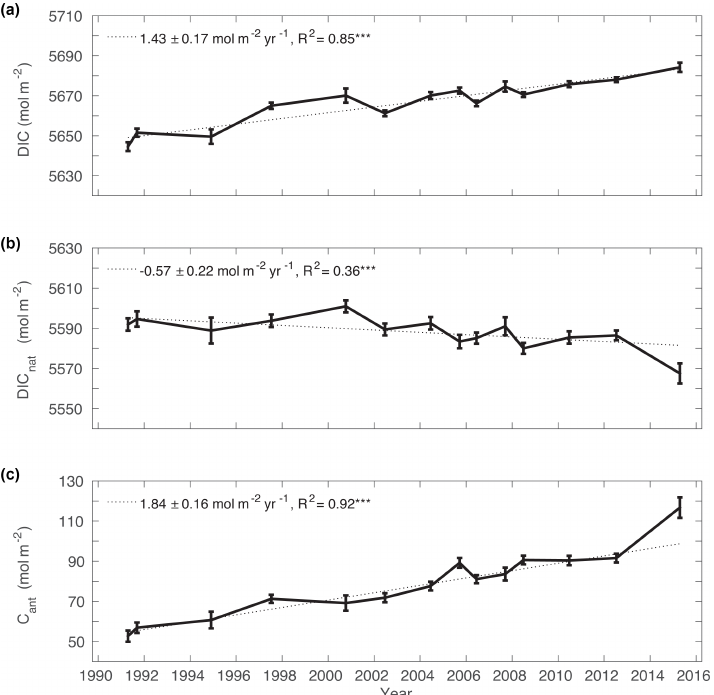
Figure 6. Total inventory for (a) DIC, (b) DIC nat and (c) C ant for Irminger Sea cruise data from 1991–2015. The rates of change between 1991 and 2015 are given, including the R-squared value of the linear regression model. Significance at the 99% level ( ∗∗∗ ) is indicated. Values of the two cruises in 1997 were averaged and are shown as one data point.